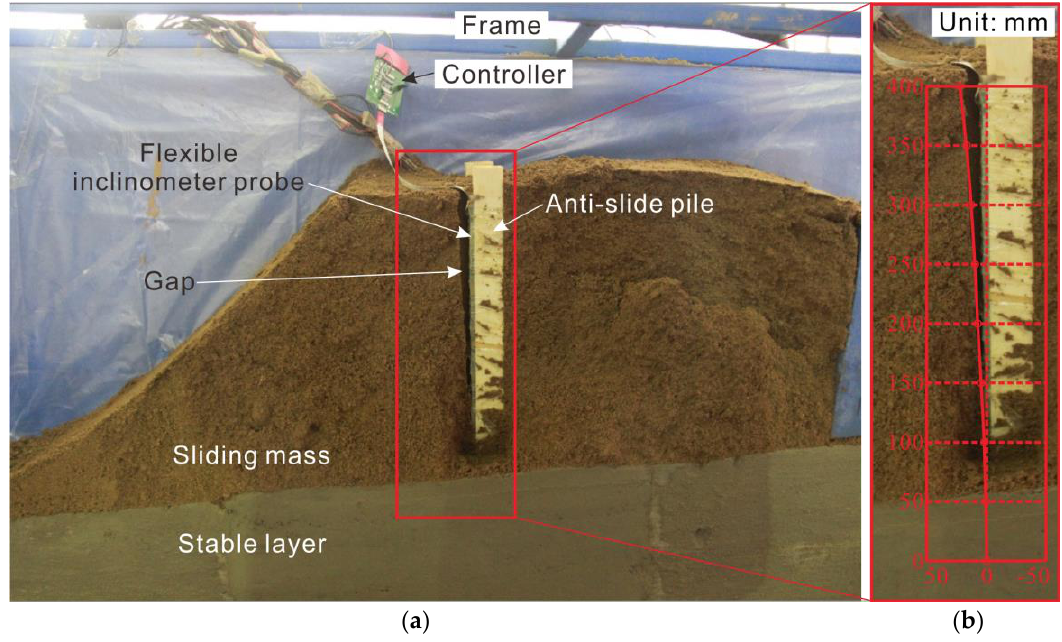
Figure 9. Physical model profile after unloading at the end of the test and comparison: ( a ) model longitudinal pic; ( b ) measurement curve at 130th min vs. the gap.